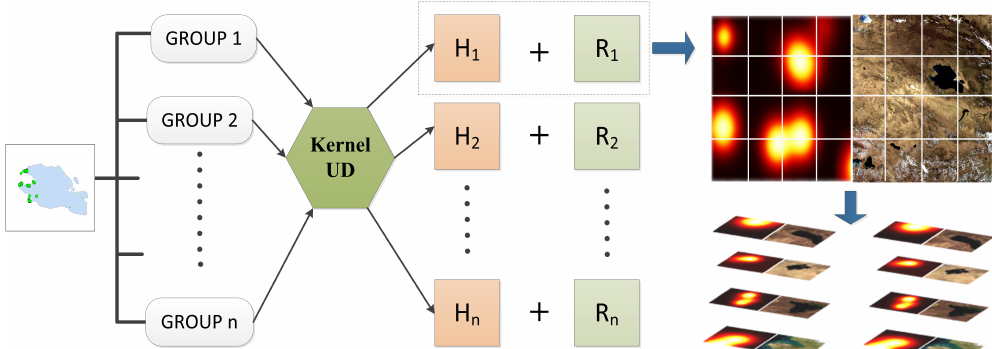
Figure 5. The pre-process procedure of building the image-based data–target pairs from source data. The GPS data are divided into time-series groups which are used to estimate home range maps via the kernel UD estimator. Then we pair each home range map ( H n ) with the corresponding remote sensing image ( R n ) to form the image